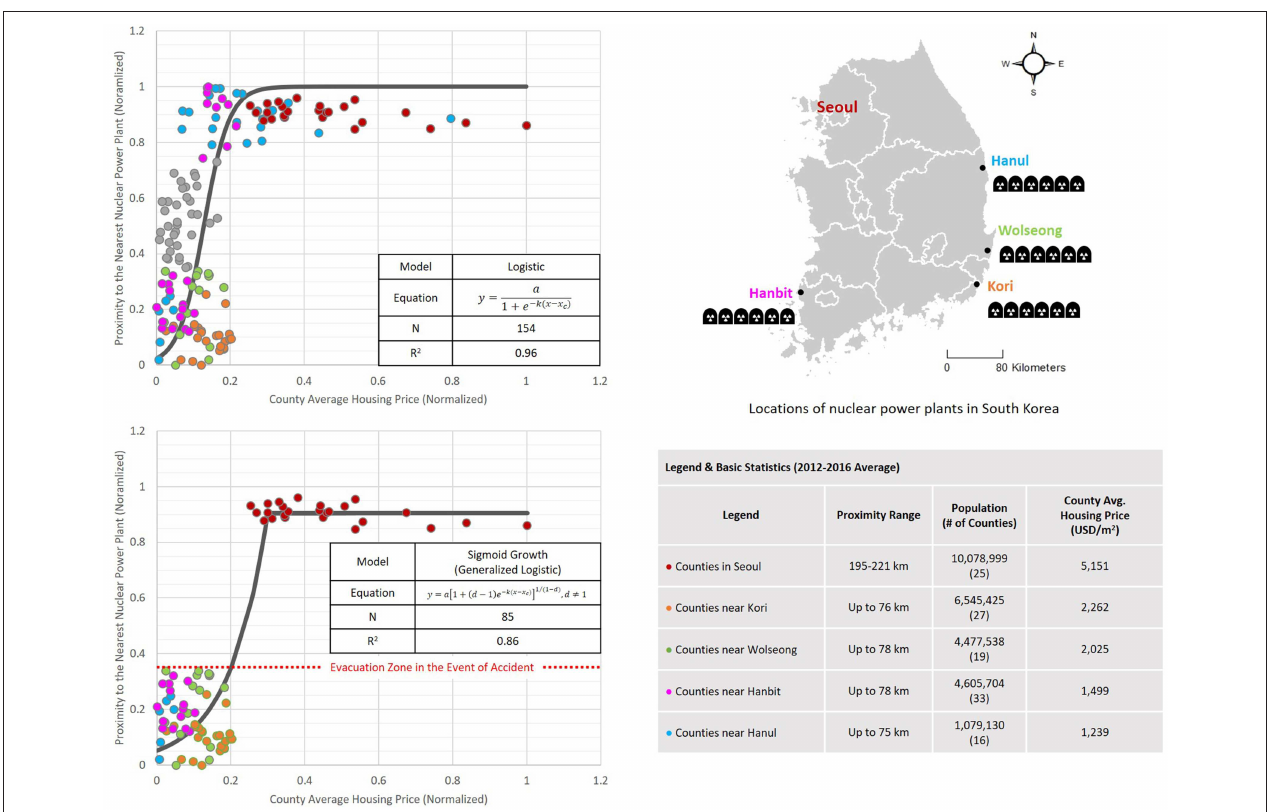
FIGURE 2 | Regressions of county average housing price to predict nuclear plant proximity in South